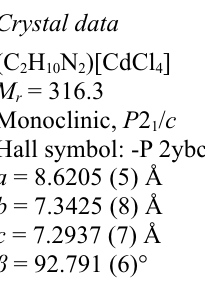
Figure 2 Packing of (NH balls (N), black balls (H). Poly[ethane-1,2-diammonium tetra- µ